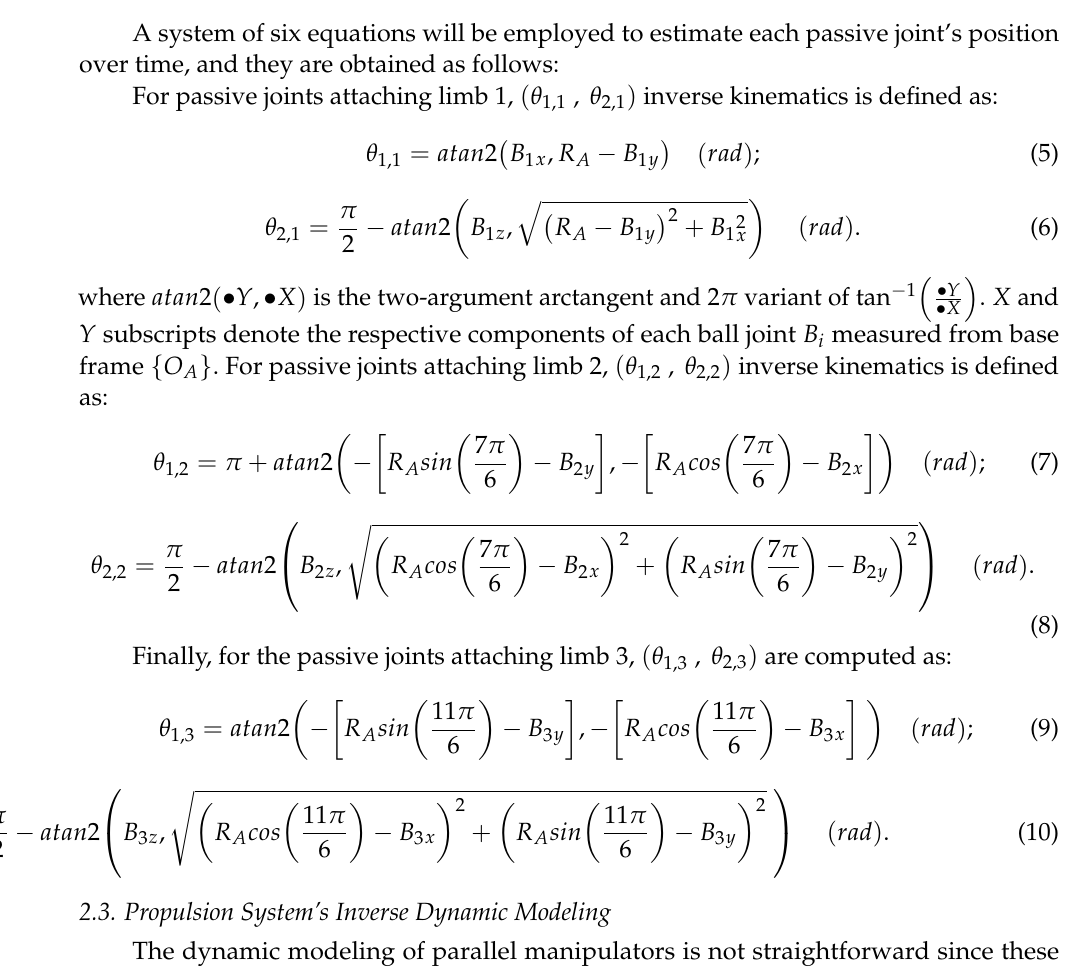
Figure 3. Revolute joints attached on the base of the fixed platform. Two rotations are studied from each universal joint.